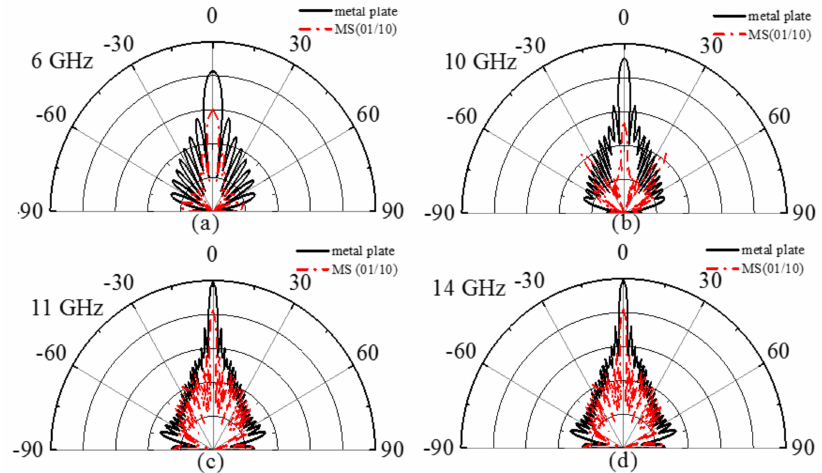
Figure 7. Scattering patterns of the 01/10 coding MS and metal plate in the XOZ -plane at ( a ) 6 GHz; ( b ) 10 GHz; ( c ) 11 GHz; and ( d ) 14